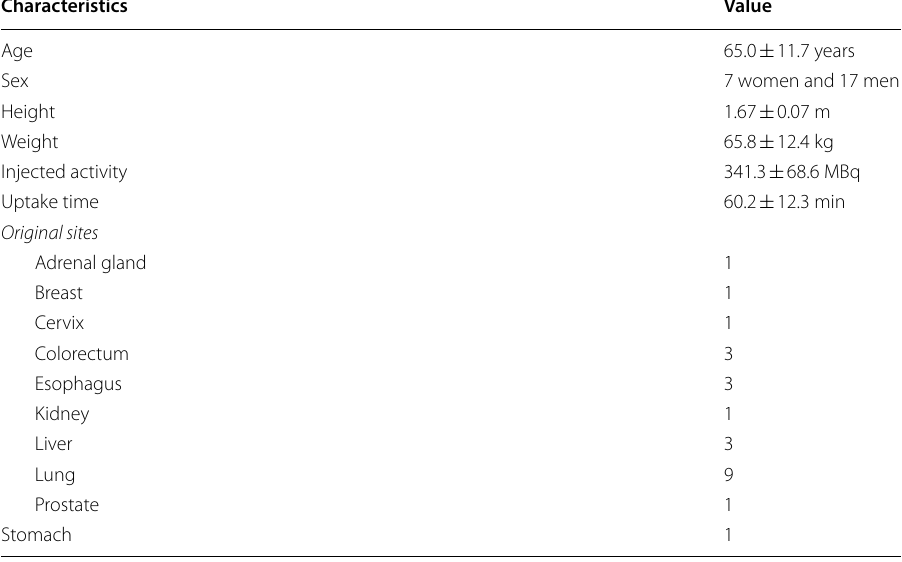
*Data are presented as mean # Data are presented as the patient counts